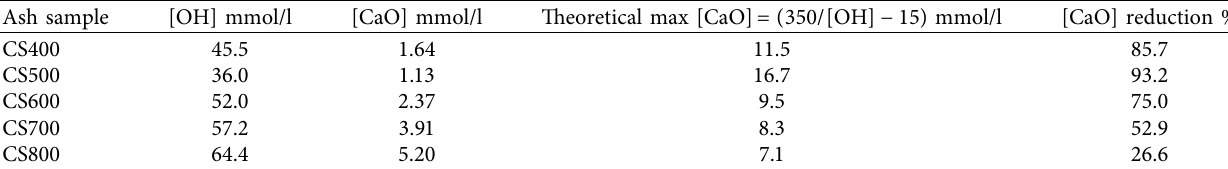
Table 2: Fratini test results.